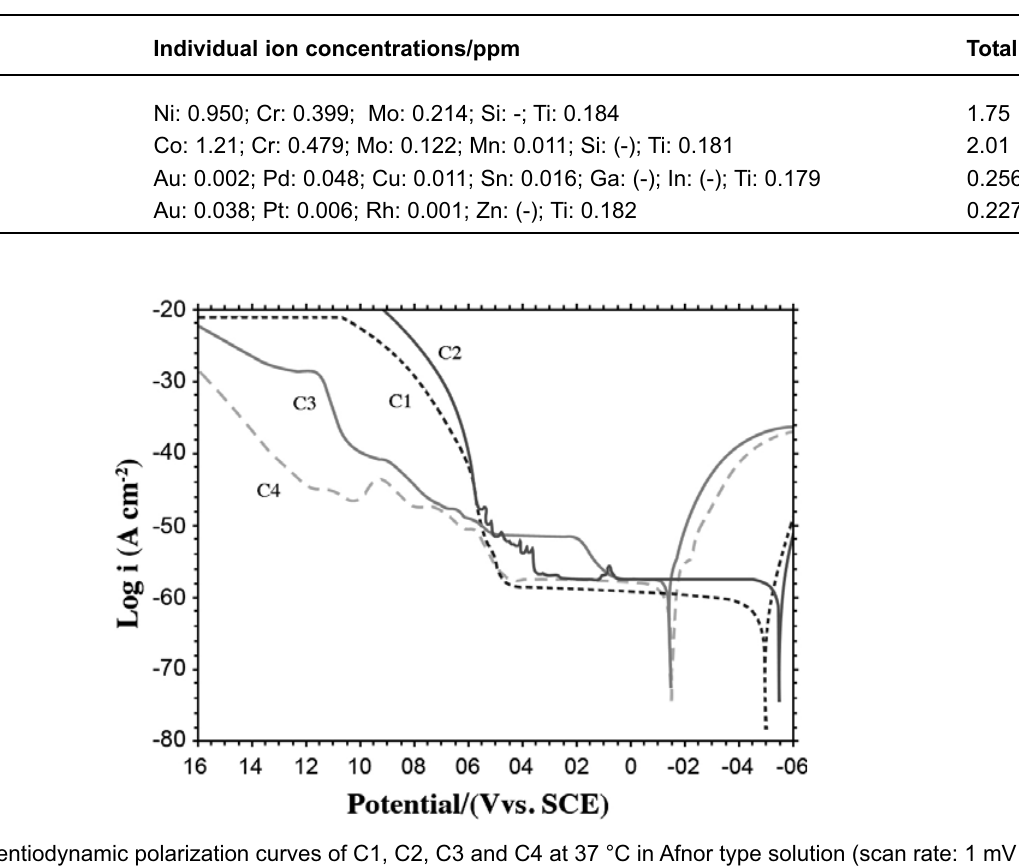
FIGURE 4- Potentiodynamic polarization curves of C1, C2, C3 and C4 at 37 °C in Afnor type solution (scan rate: 1 mV sec -1